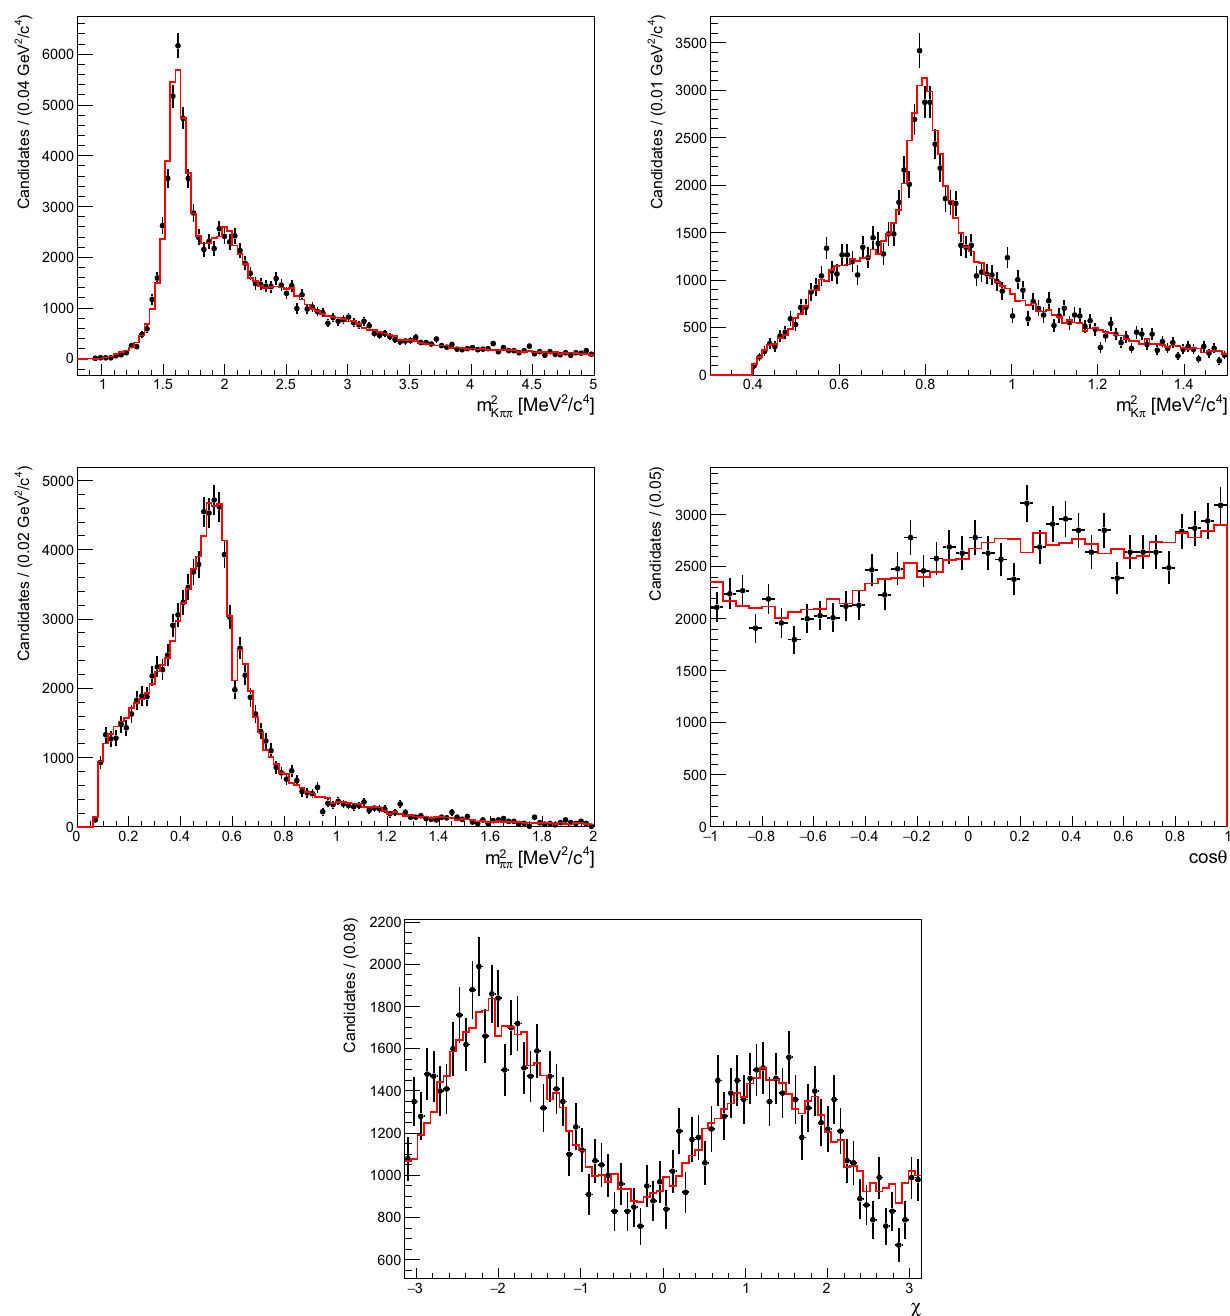
, m 2 , m 2 θ and χ )distributionsforasingledatasetof10000 B 0 → K + π − π 0 γ Fig. 7 Squaredinvariant-mass( m 2 π 0 π − )andangular(cos K + π 0 π − K + π 0 decays generated with the 23 amplitudes listed in Table 4. The red histograms represent the projections of the PDF obtained from the